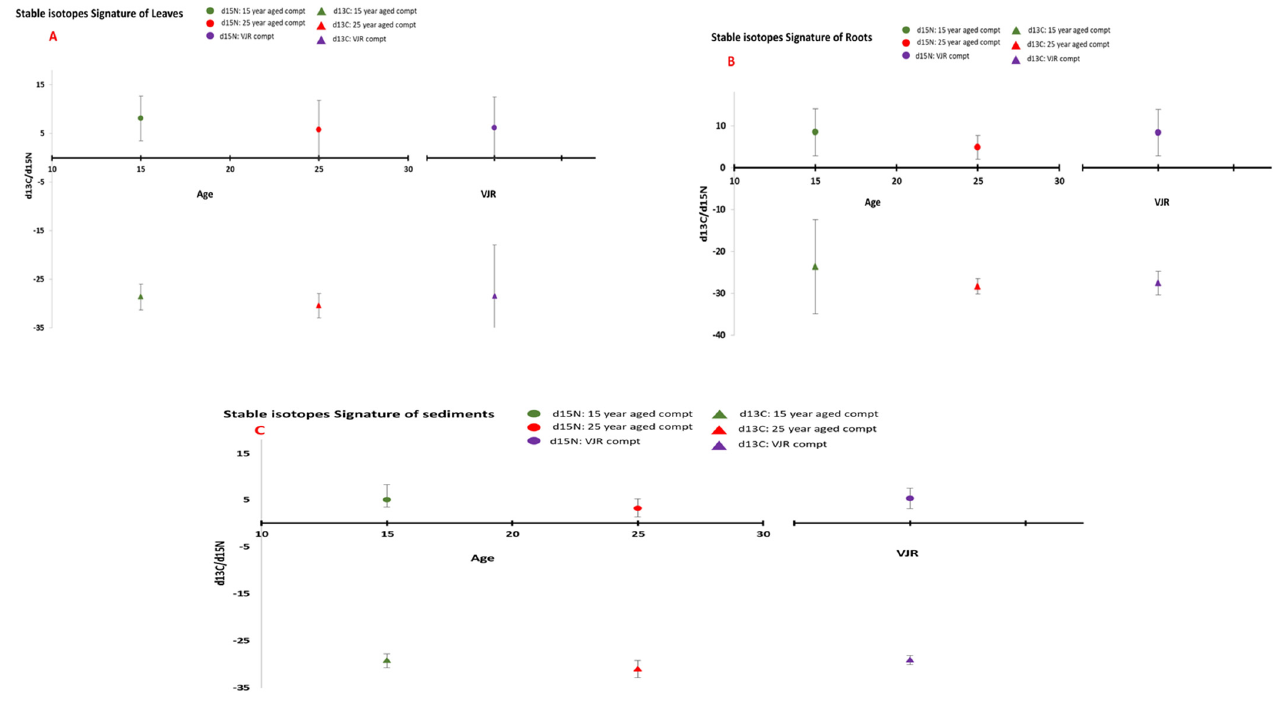
Figure 7. Stable Isotopes Concentration in ( A ) (leaves), ( B ) (roots), and ( C ) (sediments) in three age classes (mean was taken for same age compartments). Small letters (a, b, c) show different signifi- cance groups where the significance level was set as p < 0.05.4. Materials and Methods.